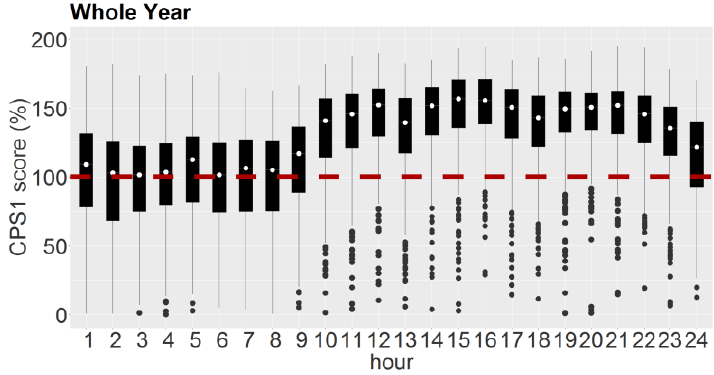
Figure 2. CPS1 scores of the Taipower system over the whole year (2015).